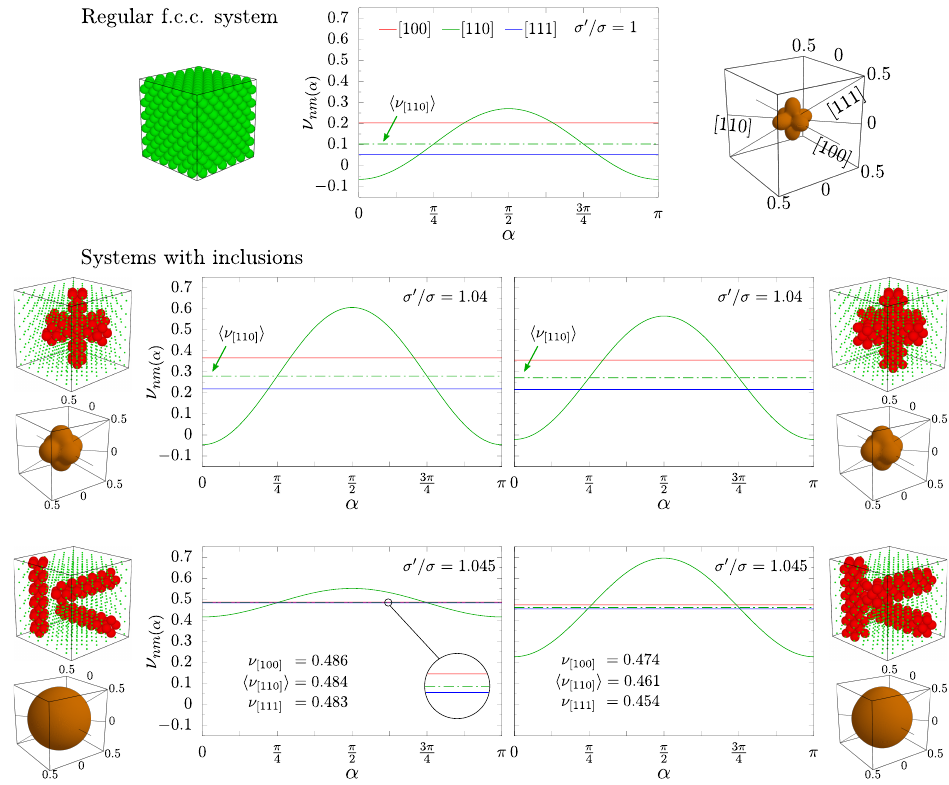
Figure 12. PR as a function of an angle α (designating (cid:126) m -direction), plotted when loading is applied in the main crystallographic directions (indicated in different colors) for the systems studied at a reduced external pressure p ∗ = 250 and common maximal σ (cid:48) / σ values for D -type and S -type systems, respectively. The values can be easily compared to a monodisperse system without inclusions (at the